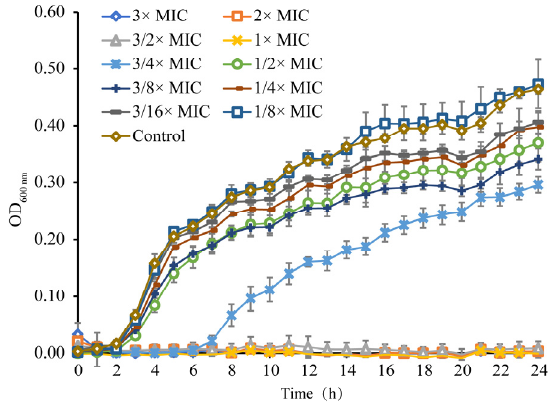
Figure 1. The growth curve analysis of S. sonnei cultured in LB broth with various concentrations of linalool. OD 600 nm , optical density at 600 nm. Bars represent the standard deviation ( n = 3).